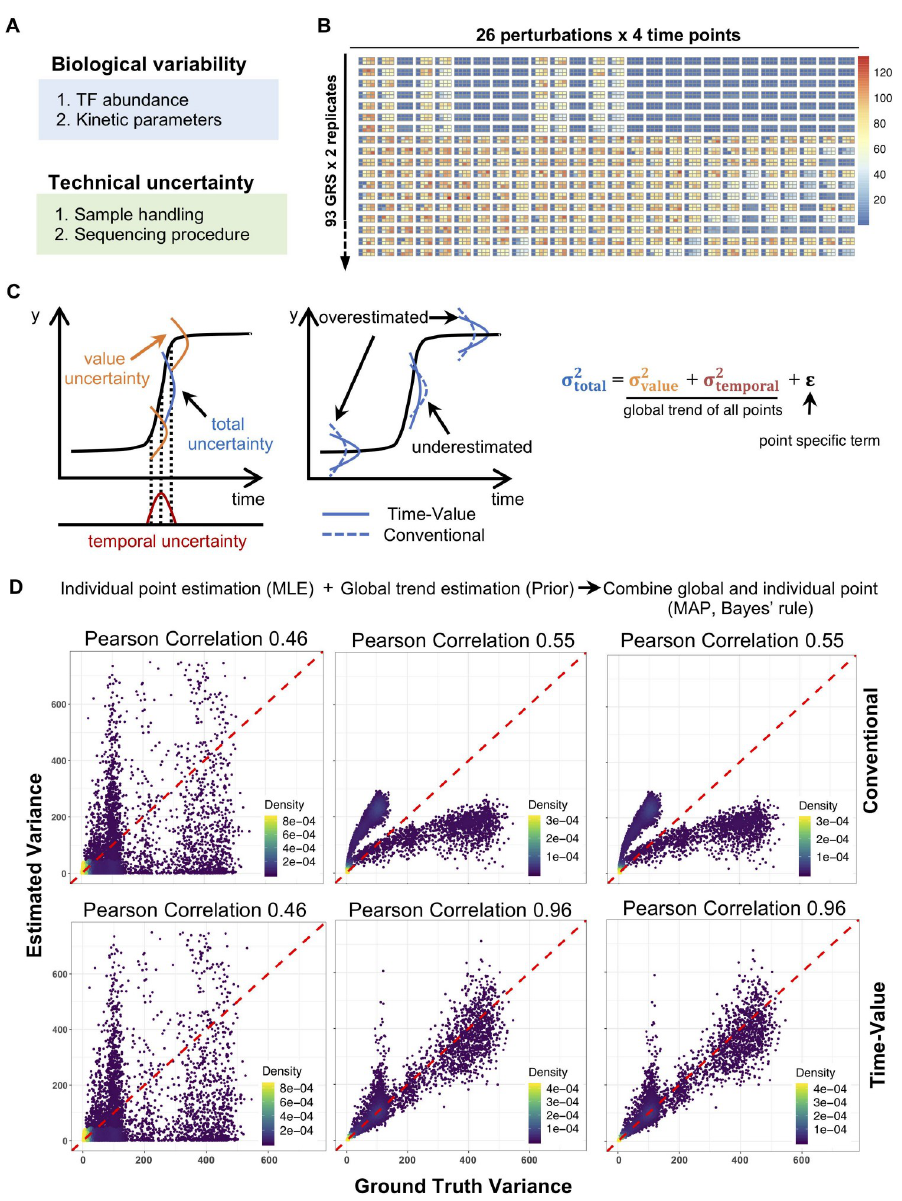
Fig 3. An error model for stimulus-response data that leverages timecourse information to avoid under and over- estimates of measurement uncertainty. (A) Uncertainty sources in data simulation. We considered both biological variability and technical uncertainty. (B) Simulated gene expression data with uncertainty (see Methods). Replicate datasets for 18 of the 93 GRSs are shown here. (C) Diagram of the time-value error model. Left panel shows how observed uncertainty can be decomposed into value and temporal uncertainties. Middle panel shows how the conventional model will under- and over-estimate data uncertainty. Right panel shows that error is decomposed into value uncertainty, temporal uncertainty, and point-specific uncertainty. (D) Uncertainty estimation with the temporal- value and conventional error model. For the left column, we estimated data uncertainty from each point using Maximum Likelihood Estimation (MLE) (98% points are shown). For the middle column, we estimated the global trend as prior. By applying Bayes’ rule, we obtained posterior estimates, right column. Pearson correlations are calculated between estimated variance and ground truth variance. Top row corresponds to the conventional model, and bottom row to our error model.